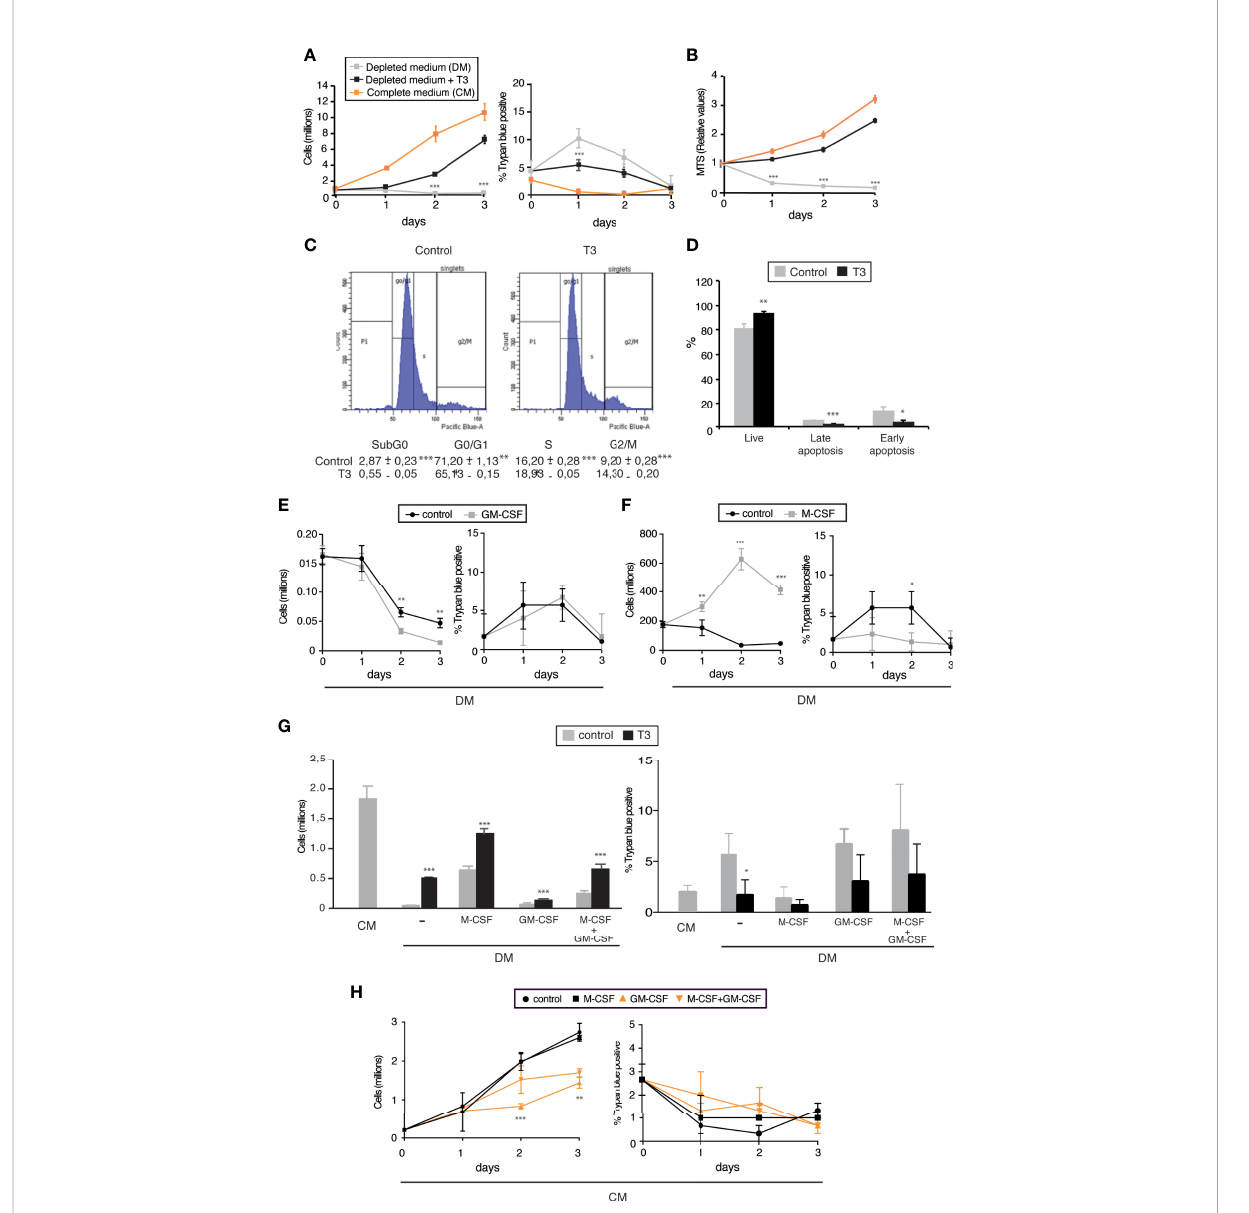
FIGURE 1 T3 is required for proliferation and viability of J2-immortalized macrophages. (A) Immortalized bone marrow derived macrophages (I-BMDM) were plated in 6-well plates in complete medium containing 10%FCS (CM) and after 5 h were either maintained in the same medium or shifted to medium supplemented with 10% thyroid hormone-depleted medium (DM) in the absence or presence of 10 nM T3 (n=9). Total cell number (left panel) as well as the percentage of Trypan blue positive cells (right panel) were counted manually in a Neubauer chamber under low power microscopy at the times indicated. (B) MTS [3-(4,5-dimethylthiazol-2-yl)-5-(3-carboxymethoxyphenyl)-2-(4-sulfophenyl)-2H-tetrazolium] levels determined in the same experimental groups in 96-well plates (n=9). (C) Cell cycle analysis by fl ow cytometry of I-BMDM cultured for 48 h in depleted medium in the absence (Control) and presence of T3. A representative plot as well as the % of cells in the different stages of the cell cycle (n=3) are shown. (D) The percentage of total cells that were PI-/Annexin V- (alive cells); PI+/Annexin V- (early apoptosis) and PI+/Annexin V+ (late apoptosis) was determined by fl ow cytometry in I-BMDM grown in depleted medium in the absence and presence of T3 for 48 h (n=3). (E) I-BMDM were cultured in 24-well plates in complete medium, shifted to depleted medium (DM) after 5 h and incubated for the times indicated in the absence (control) and presence of M-CSF (40 ng/ml). The number of cells (left panel) as well as the percentage of Trypan blue positive cells (right panel) were scored manually under the microscope (n=3). (F) Cells were cultured as in E with and without GM-CSF (20 ng/ ml) and the number of cells counted at the times indicated (n=3). (G) I-BMDM were cultured in complete medium (CM) or shifted after 5 h to hormone-depleted medium (DM) supplemented with M-CSF and/or GM-CSF in the presence and absence of T3. The number of total (left panel) and Trypan blue positive cells (right panel) was scored 48h later (n=6). (H) Cells were plated in complete medium (CM) and incubated in the same medium with M-CSF and/or GM-CSF. The total number of cells (left panel, as well as the number of Trypan blue positive cells were determined at the times indicated. Data are means ± SD. *p < 0.05, **p < 0.01, ***p <